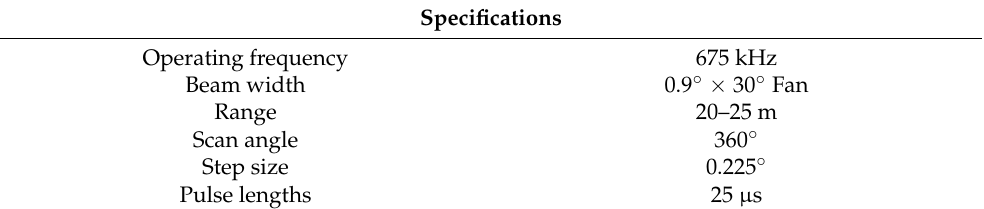
Table 4. Technical specifications of the sonar head used during the